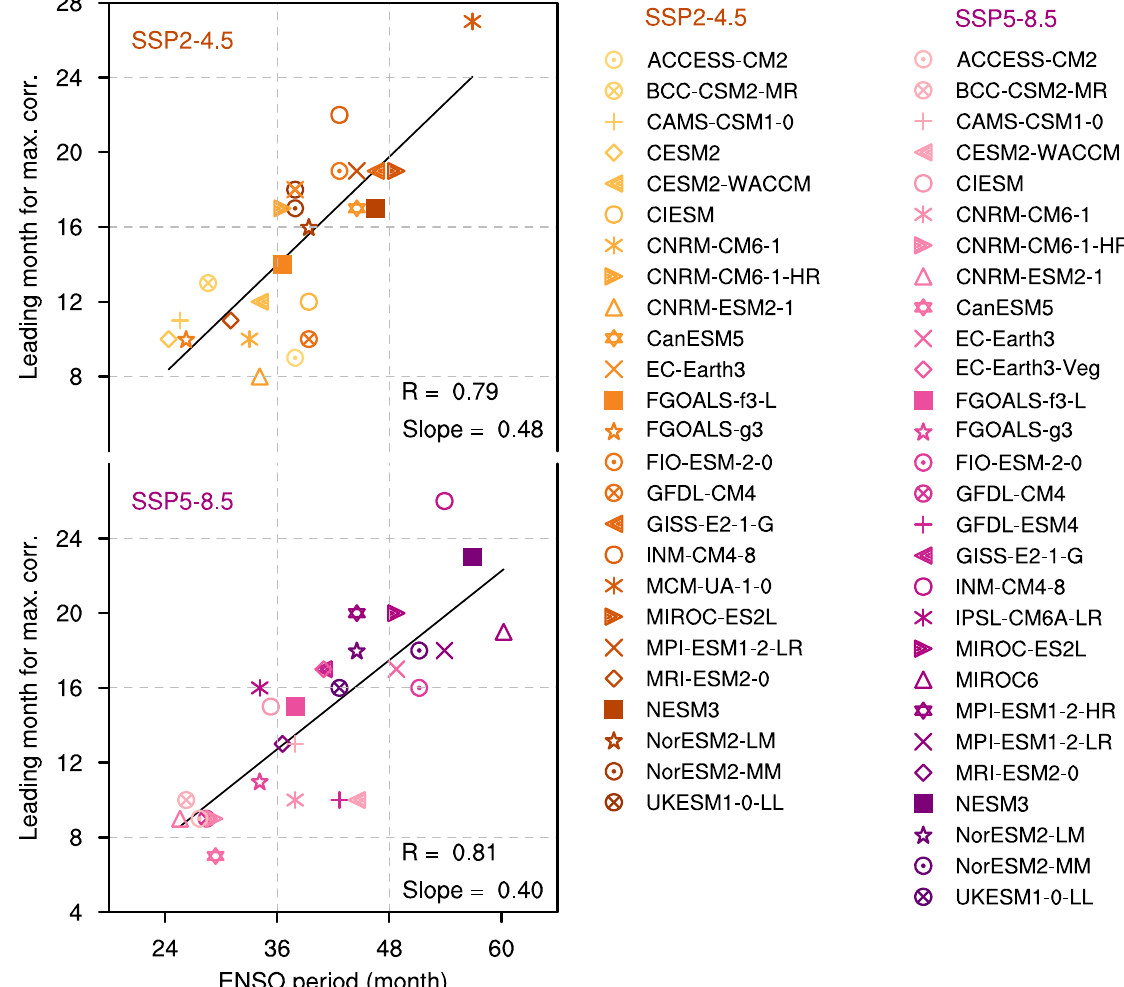
Fig. 3 Phase relationship of NTA SST anomalies with ENSO in future warming simulations. Scatterplot of ENSO period and lead-time at which negative correlation coef fi cients are maximized for boreal spring North Tropical Atlantic sea surface temperature anomaly with the subsequent Niño3.4 index for different climate models (different markers) in Shared Socioeconomic Pathways (SSP) 2-4.5 (red) and SSP5-8.5 (purple) scenarios. The linear fi ts (solid black) are displayed together with respective correlation coef fi cient R and